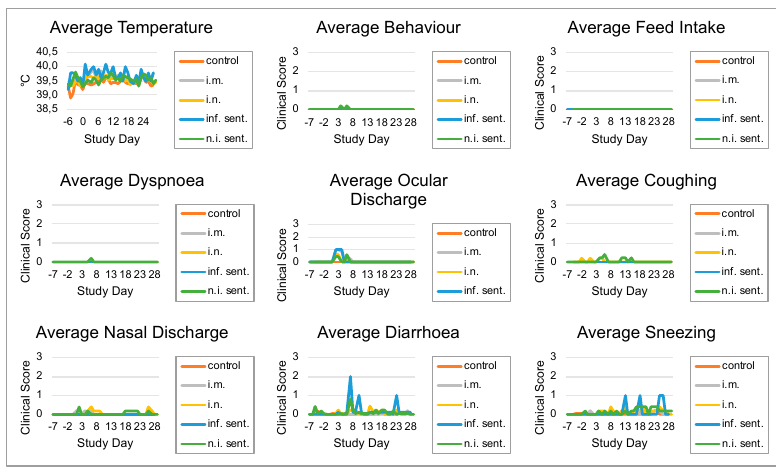
Figure 1. Pathogenicity of lateral-shaking inducing neuro-degenerative agent (LINDA) in piglets. A total of 21 piglets were divided in five groups: five negative control, five intramuscularly (i.m.) infected and five intranasally (i.n.) infected animals as well as three sentinel animals for the i.m. and three sentinel animals for the i.n. group. The animals from the i.m. and i.n. infection groups were inoculated with LINDA (1 × 10 7 TCID 50 / mL) on study day 0. Body temperature, behavior, feed intake,